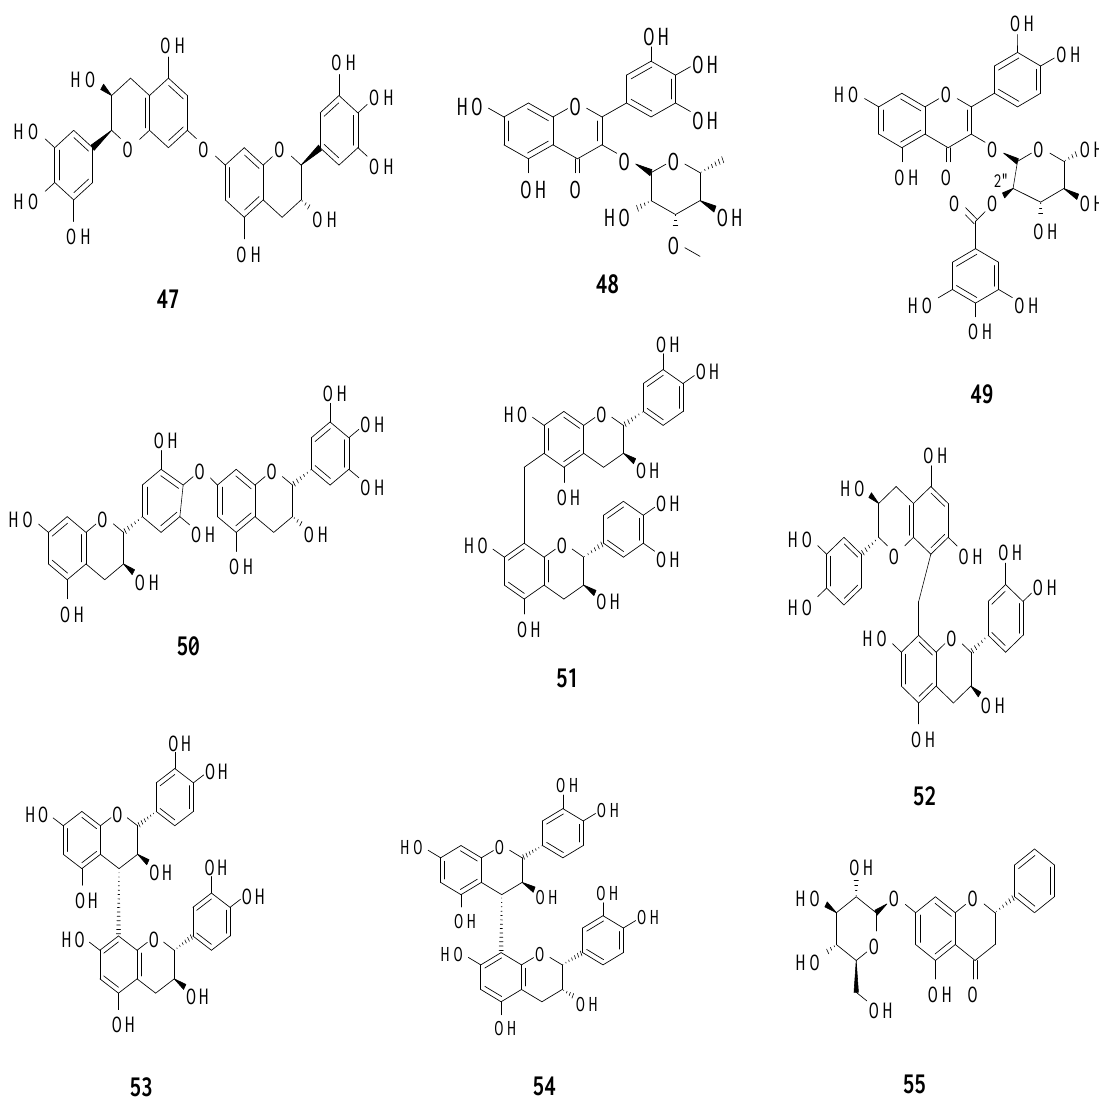
Figure 14. The flavonoids isolated as α -glucosidase inhibitors from P. anserine [51]. Hmidene et al. studied the effect of five simple flavonols 56a – e and glucuronirated flavonols 56f – i from Tamarix gallica on α -glucosidase inhibitory activity [52]. The acarbose was used as a positive control. The chemical structures of all the compounds tested are elucidated in Figure 15. It was reported that all nine compounds showed a dose-dependent inhibition and portrayed higher inhibition compared to acarbose. Based on compounds 56a and 56e , it was suggested that the hydroxyl group at C3′ with glucuronic acid and methyl ester was responsible for α -glucosidase inhibition.